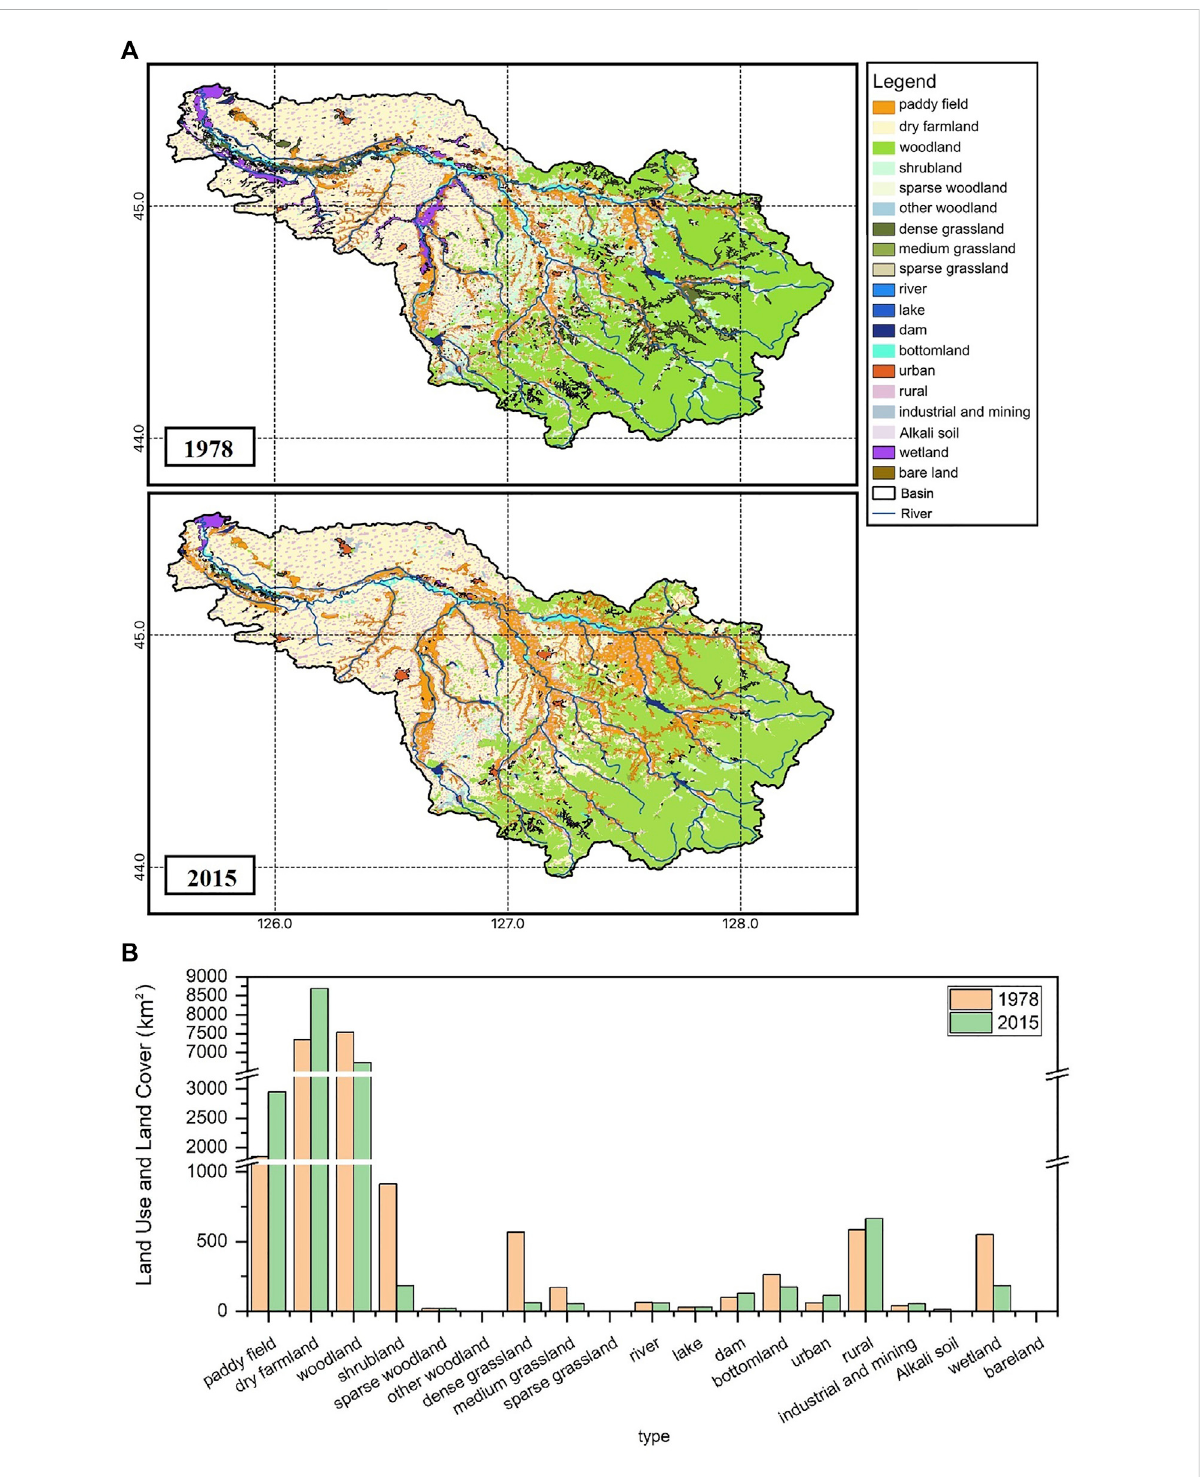
FIGURE 2 Degression of wetland and increase of paddy fi elds in the LRB from 1978 to 2015 (A) , and the comparisons of each type (B) .